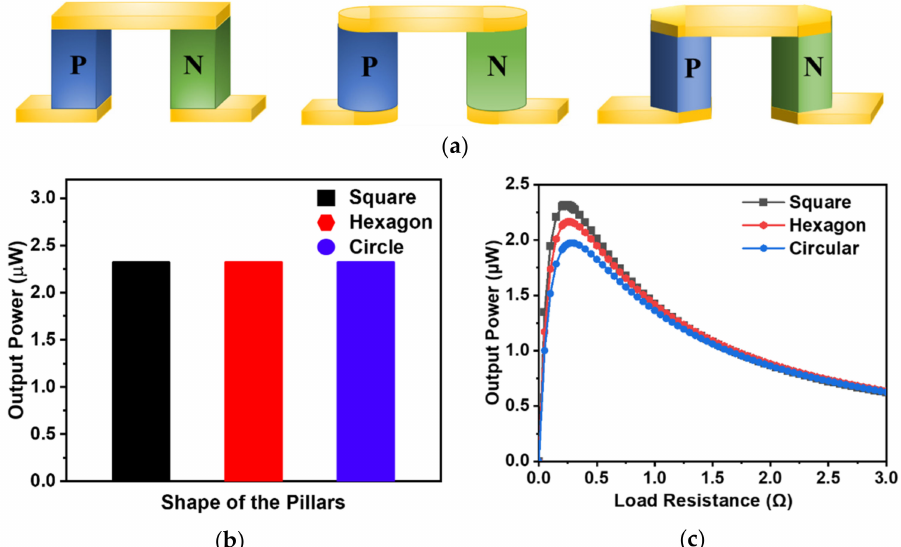
Figure 2. ( a ) Single-leg pair TEGs with different shapes of the pillars; ( b ) output power when the cross-sectional area of different pillar shapes are constant, and ( c ) output power vs. load resistance for different pillar shapes at 5 K temperature gradient with varied cross-sectional areas (keeping the effective area of the device constant).